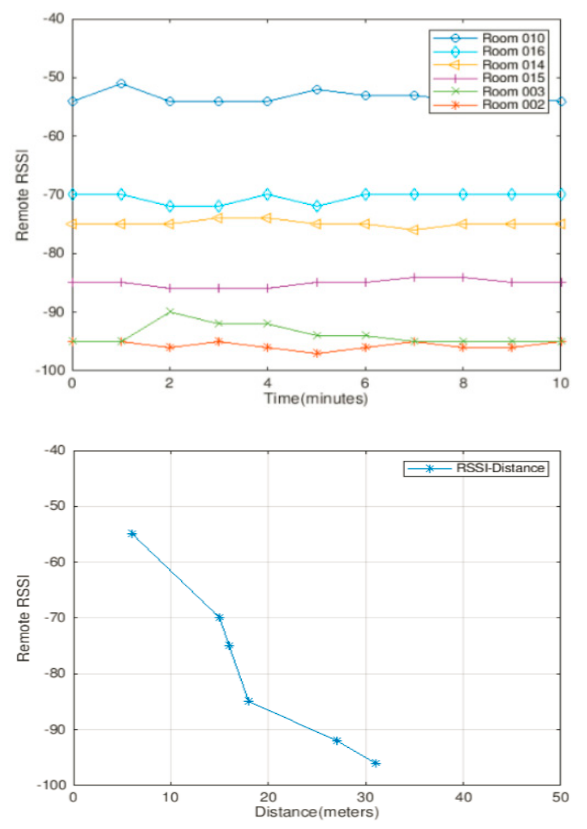
Figure 9. RSSI value between sensor nodes and gateway.